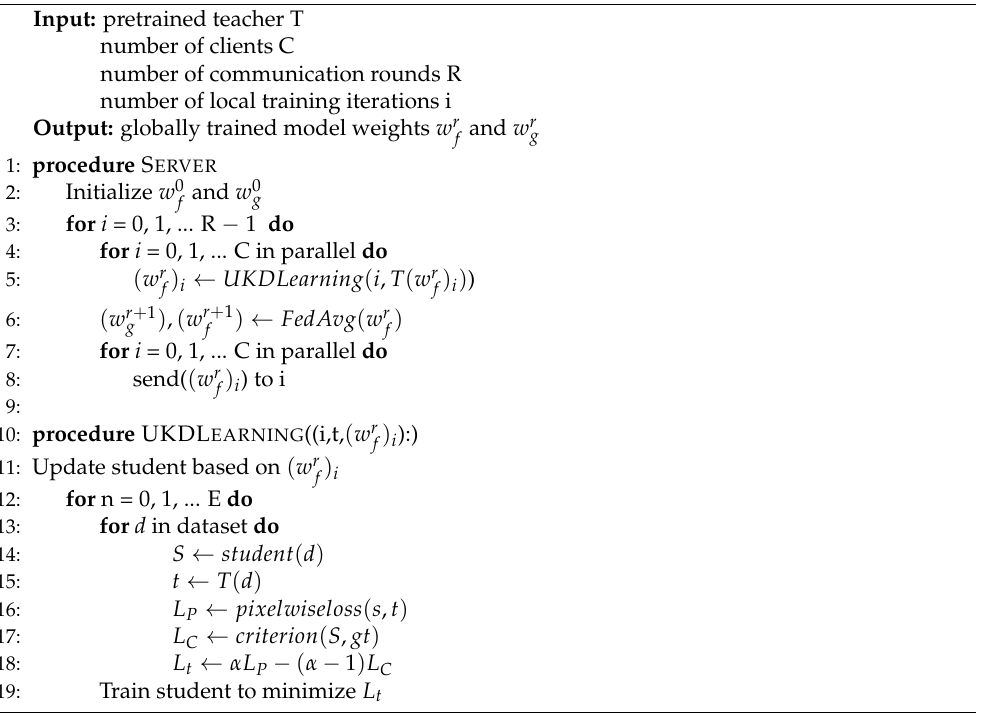
Algorithm 1 Federated UNet with knowledge